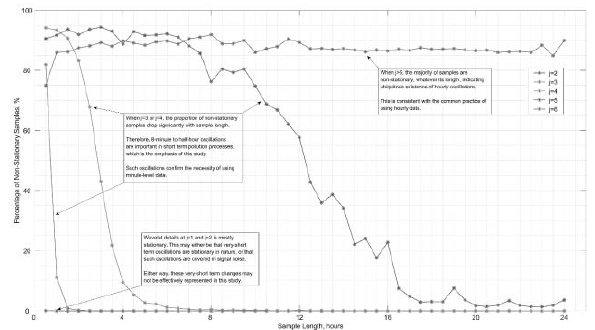
Figure 5 . Sample stationarity distribution on different frequencies (Fan et al.,